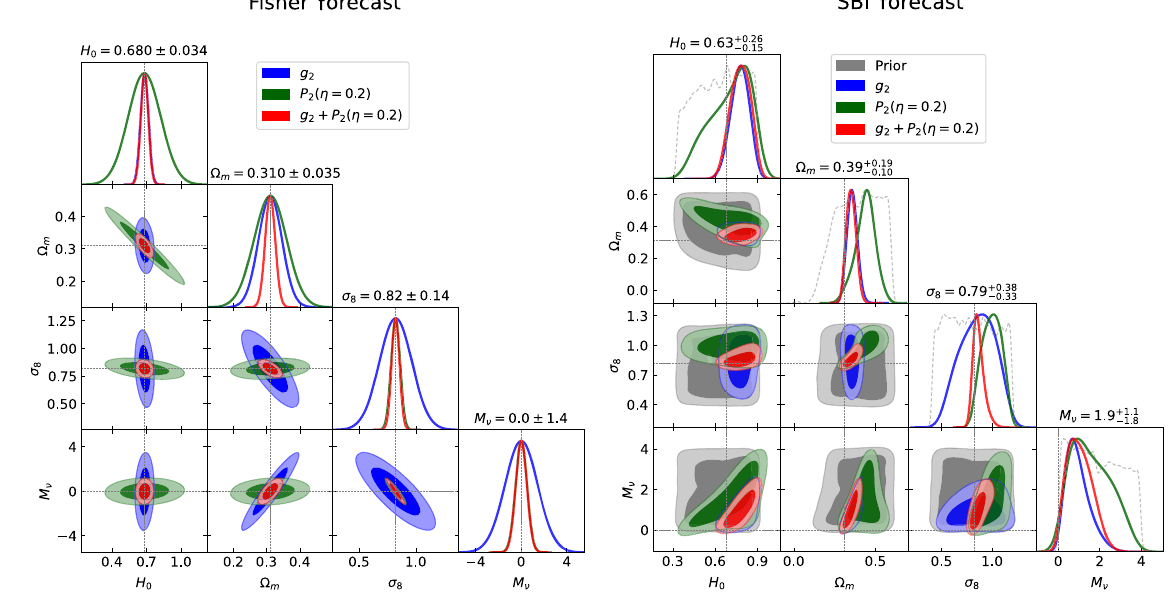
FIG. 12. Forecasted constraints on key cosmological parameters using the pair correlation function g 2 and the pair-connectedness function P 2 , using a Fisher forecast (left) and simulation-based inference (right). The dark (light) ellipses represent our 68% (95%) confidence intervals on the various parameters possible from a single galaxy simulation (as in Fig. 2), with the gray regions showing the prior used in the simulation-based approach (from 8192 simulations). We show results for four parameters: H 0 , giving the Universe ’ s P m ν . The diagonal figures give the expansion rate, the matter density Ω , the clustering amplitude σ 8 , and the total neutrino mass m marginalized constraints on single parameters, while the off diagonals show the correlations; e.g., the bottom left-hand panel shows the correlation between h and σ 8 . We find that P 2 is a poor predictor of H 0 and Ω (shown by the broad contours), but can tightly constrain m σ 8 . The combination g 2 þ P 2 significantly increases the precision by which this parameter can be measured, and we find similar results from the Fisher forecasts (which are, in general, overoptimistic), and the simulation-based inference (which is usually